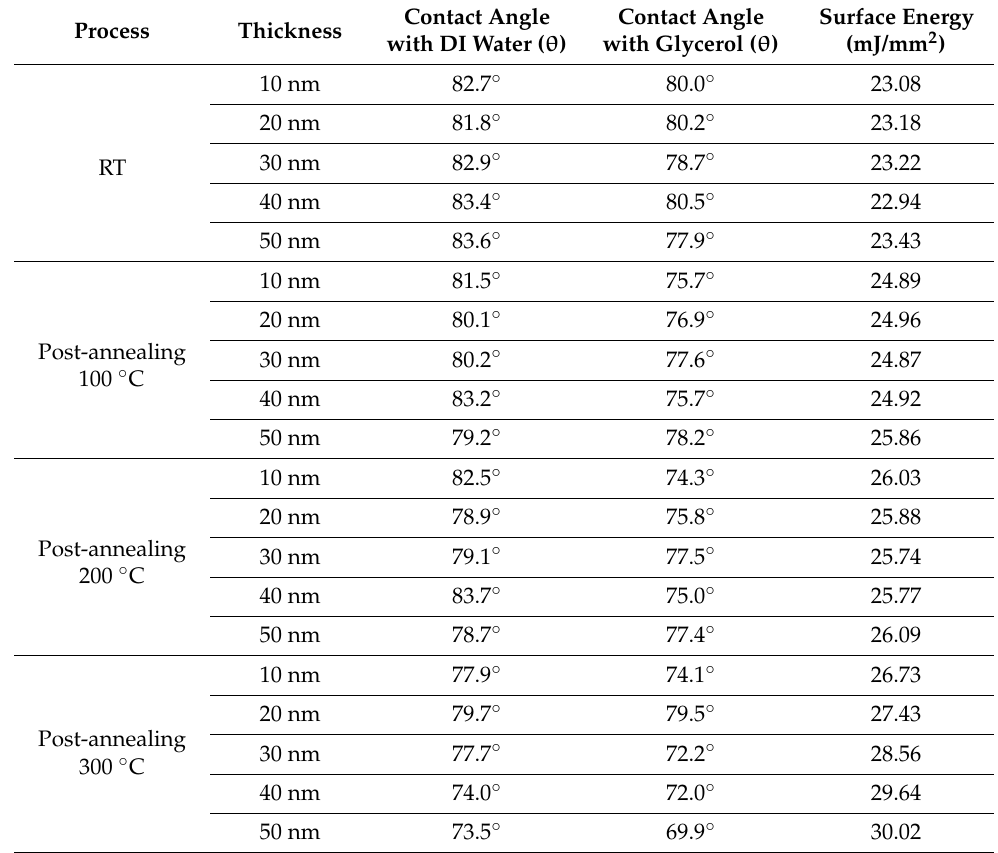
Table 2. Comparing the contact angles and surface energy for Co 60 Fe 20 Y 20 thin films from different fabrication processes.